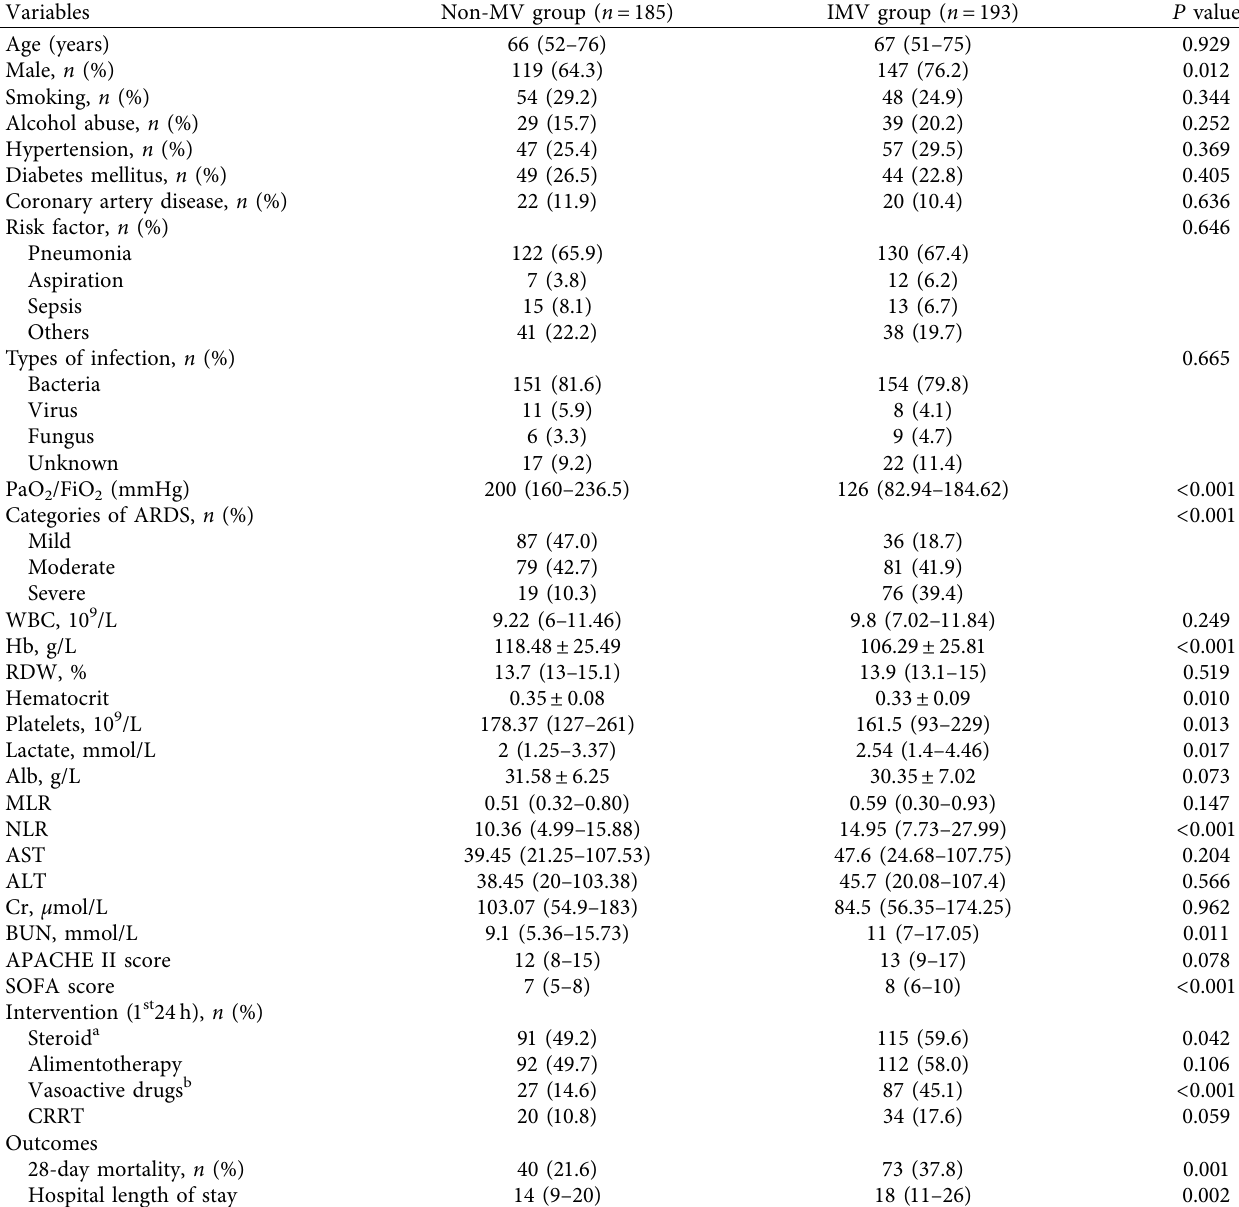
Table 1: Comparisons of baseline characteristics between the nonmechanical ventilation group and the invasive mechanical ventilation